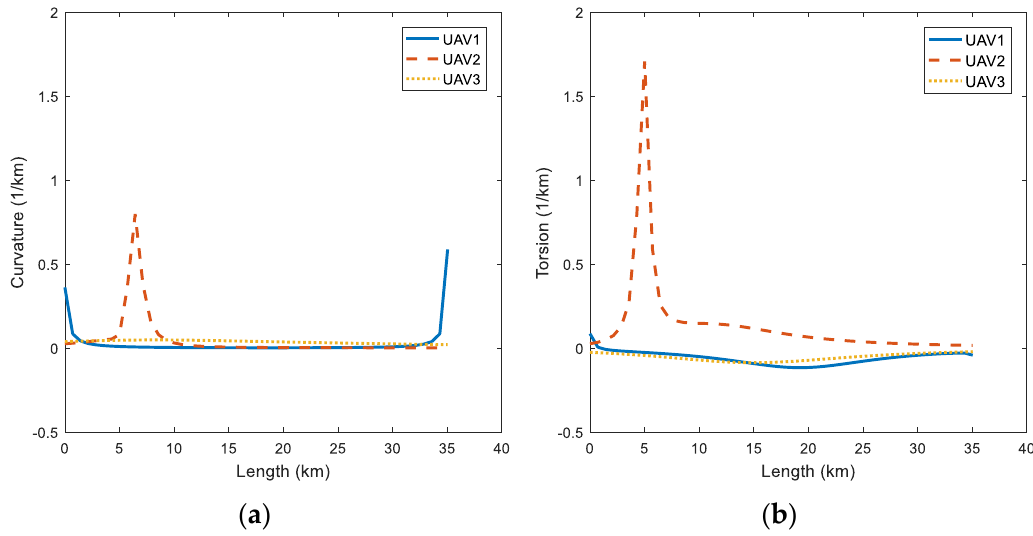
Figure 7. Curvature and torsion variations with respect to path length. ( a ) Curvature; ( b ) torsion.